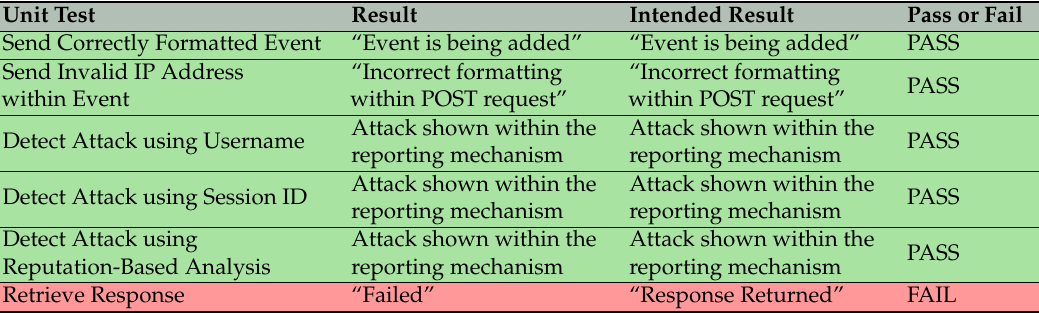
Table 2. BlackWatch unit test